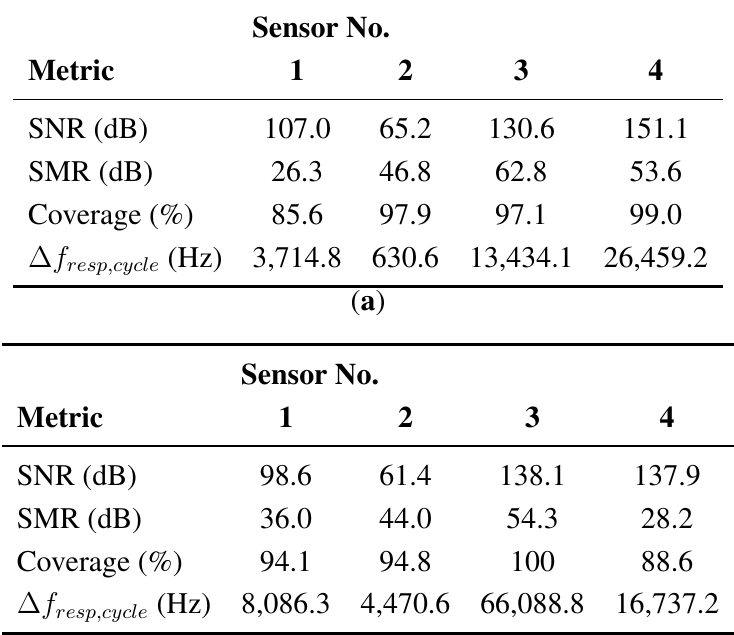
Table 4. Performance metrics of the different sensor positions during normal breathing in ( a ) a standing and ( b ) a sitting posture. Values are averaged for all subjects (the total signal length is 16 min). ∆ f is the mean peak-to-peak frequency change of a respiratory resp,cycle cycle. SNR, signal-to-noise ratio; SMR, signal-to-motion ratio. Sensor